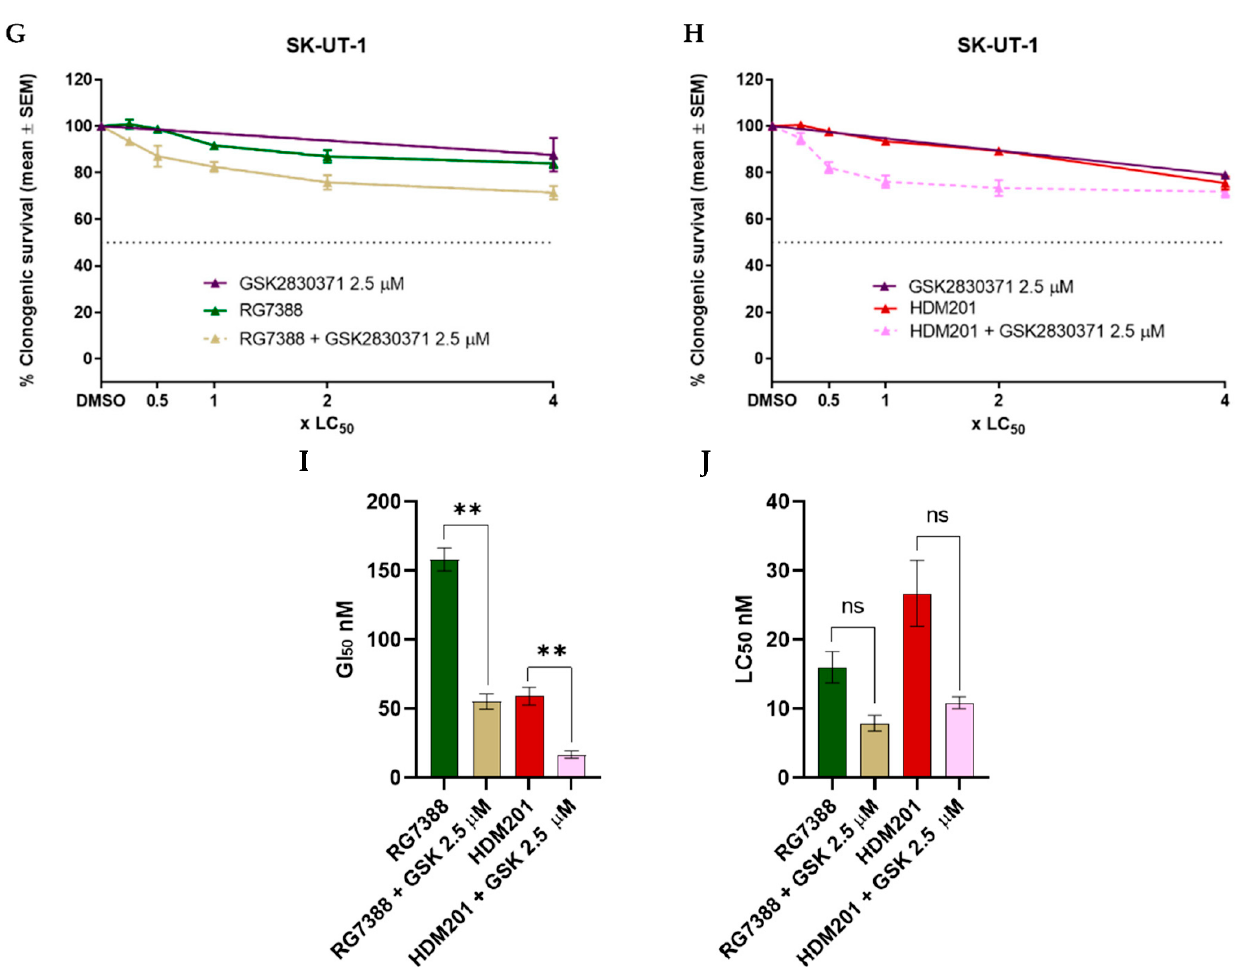
Figure 3. Effects of MDM2 inhibitors in combination with 2.5 µM GSK2830371 on cell proliferation and clonogenic sur- vival. Percentage proliferation or clonogenic survival are expressed relative to DMSO-treated control. Growth inhibition curves for MES-SA cells treated with 2.5 µM GSK2830371 and ( A ) RG7388; ( B ) HDM201; Dose–response curves following clonogenic survival assays for MES-SA cells treated with 2.5 µM GSK2830371 and ( C ) RG7388; ( D ) HDM201; ( E – H ) the same as ( A – D ) but for p53 mutant SK-UT-1 cells; ( I ) GI 50 values for MES-SA when treated with single-agent MDM2 inhib- itor or combination with 2.5 µM GSK2830371 as determined from growth inhibition assays in ( A ) and ( B ); ( J ) LC 50 values for MES-SA when treated with single-agent MDM2 inhibitor or combination with 2.5 µM GSK2830371, as determined from clonogenic survival assays in ( C ) and ( D ). Statistical significance was evaluated using a paired t -test, ** = p < 0.01. GSK, GSK2830371; ns, not significant.